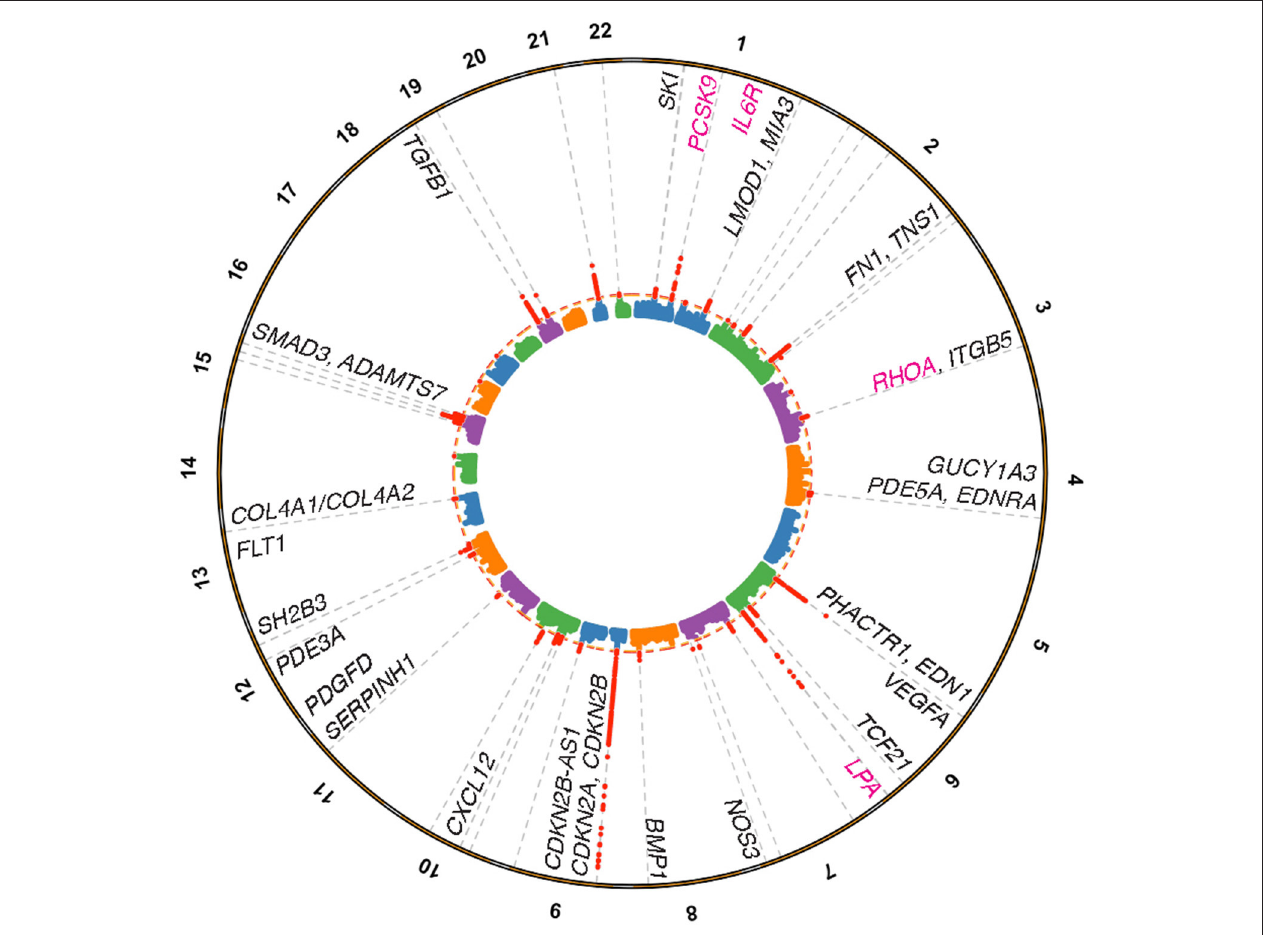
FIGURE 1 | Coronary artery disease loci harboring genes linked to vessel wall functions. Manhattan plot depicting genome-wide significant loci identified from the Nelson et al. ( 15) meta-analysis for CAD based on a 5% false discovery rate using the pilot UK Biobank data. Loci were annotated through a combination of gene expression, epigenomic features, eQTL, and literature based searches. Vessel wall gene symbols are shown above associations in red, with dotted orange line representing P = 5.0 × 10 − 8 . Pink gene symbols represent loci with either approved or evaluated treatments for